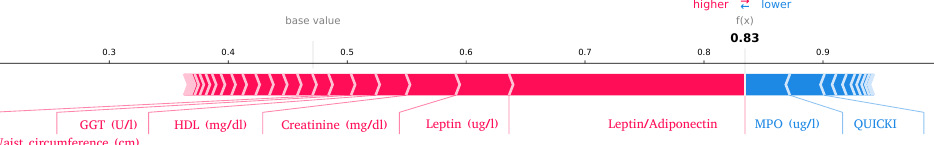
Figure 4. SHAP plot for a specific sample. This plot shows how the classifier output (0.83) is calculated from the different attributions (positive or negative) of the different predictors. Only the most important attributes are labeled for